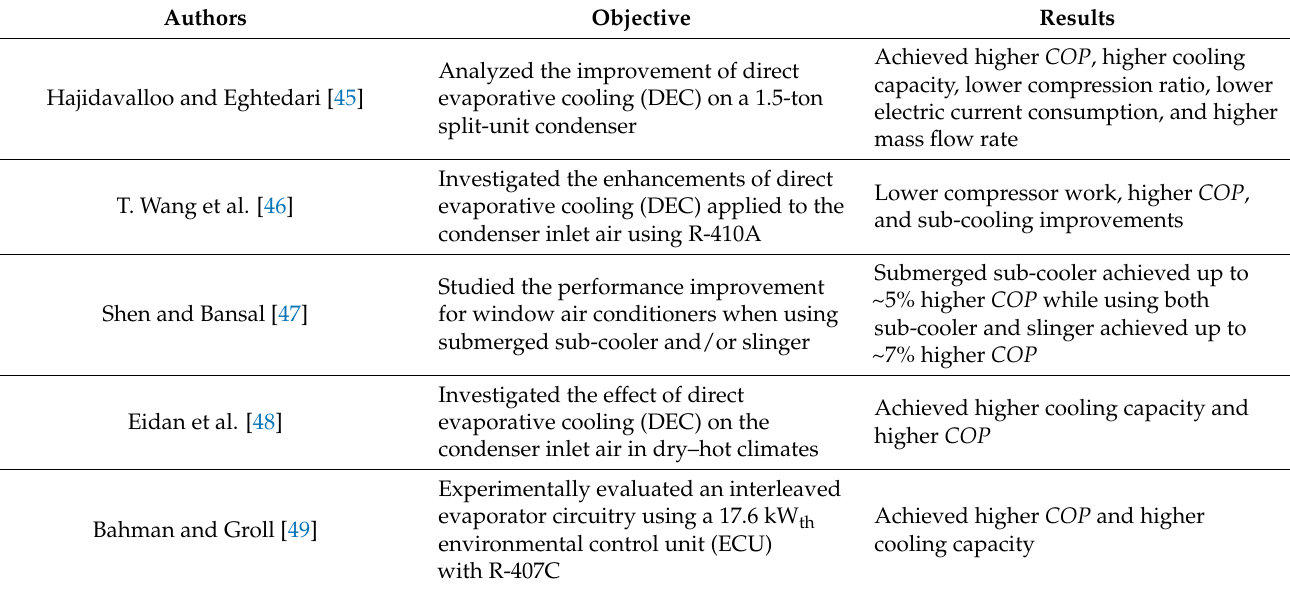
Table 3. Summary of studies related to air conditioner improvements at HAT